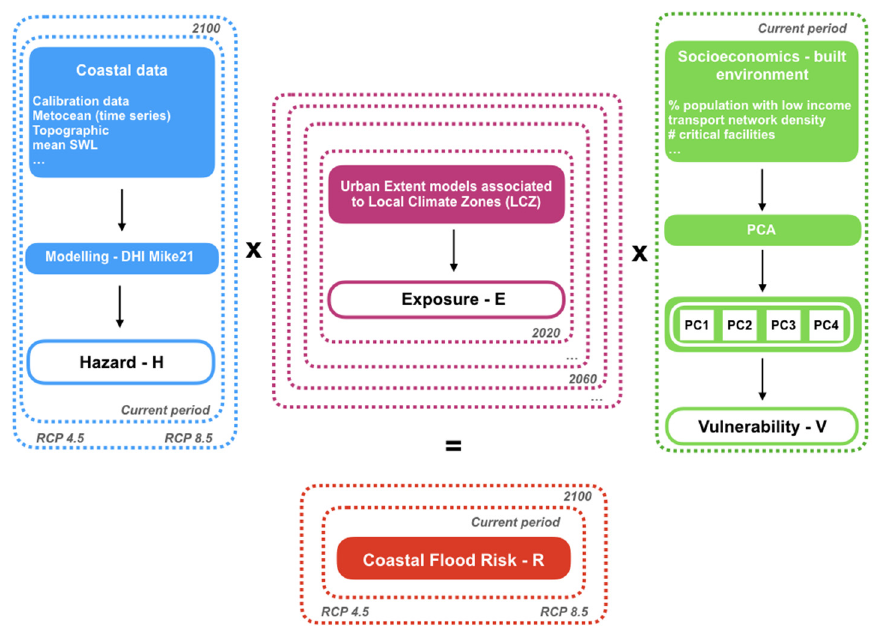
Figure 2. Workflow used in this study. Hazard to coastal flood has been simulated by means of a software package for hydrodynamic modelling (DHI Mike 21©). This allows us to simulate the inundation depth for the region of interest for the current period and for two different RCPs scenarios in 2100 and to derive the Hazard index (H). Exposure to coastal flood has been modelled based on Corine Land Cover (CLC) associated with Local Climate Zones (LCZ) to compute the percentage of urban and non-urban areas across SAs. The Exposure index is then computed for the current period up to 2100. The vulnerability assessment is based on census socioeconomics and open data, which have been processed through a methodology based on a Principal Component Analysis (PCA). The Vulnerability index (V) is then computed for the current period. The Risk Index (R) is the product of H, V and E across SAs for the current period and for 2100 under RCP 4.5 and 8.5 and then cate- gorized into five classes. 3.1. Coastal Inundation Modelling In this work, the inundation depth (expressed as the total water depth locally reached in one cell) has been used as the hazard indicator for coastal flood risk and has been sim- ulated using the DHI Mike 21©, which is a leading software package for 2D modelling of hydrodynamics, waves, water quality, ecology and sediment dynamics in general. The Mike 21© includes cell wet and dry functionalities which allow the assessment of the propagation and dynamic of the inundation over the floodplain. This model was employed to assess the likely depth of coastal inundation for County Dublin based on projecting a past surge event (specifically, Cyclone Xaver, 2013) under two mean Sea Level Rise (mean SLR) scenarios at 2100. The mean SLR estimated for the end of the century is 0.45 m and 0.81 m under RCP 4.5 and 8.5, respectively. Cyclone Xaver was a winter storm that developed on 4 December 2013, characterised by high wind speeds and low atmospheric pressure which occurred during a spring tide phase. The storm persisted for around six days along the north coast of Europe, causing one of the worst storm surges for decades in the North Sea [50,51]. The storm’s low-pres- sure system formed off the coast of Greenland, passed northwest of Ireland, crossed the UK and moved to northern Europe resulting in a cold air outbreak southward of the North Sea and in strong northwest winds [52]. The convective process was associated with freez- ing precipitation and strong wind gusts all over the affected regions. The storm had sev- eral serious impacts on energy and coastal societal infrastructures in general across Ire- land and other countries [51].